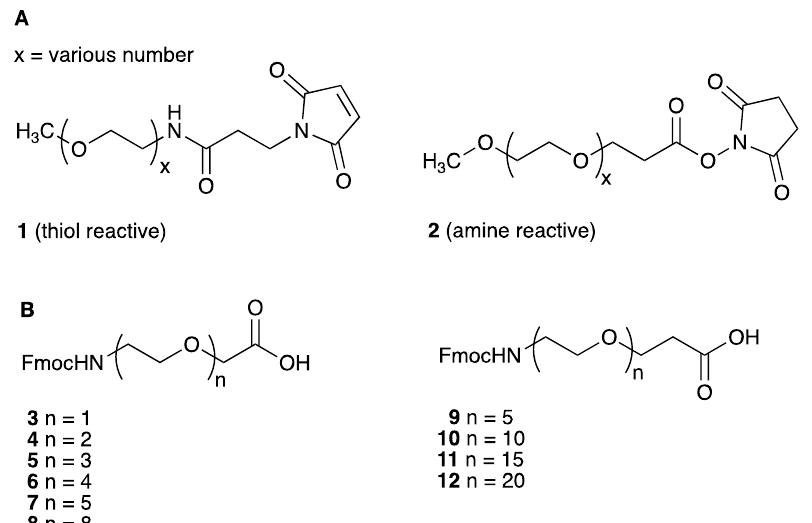
Figure 1. ( A ) Examples of common PEGylating reagents. ( B ) Structure of commercially available PEGs containing an acetyl handle ( 3 – 8 ) or a propionyl handle ( 9 – 12 ); n = number of ethylene glycol units.